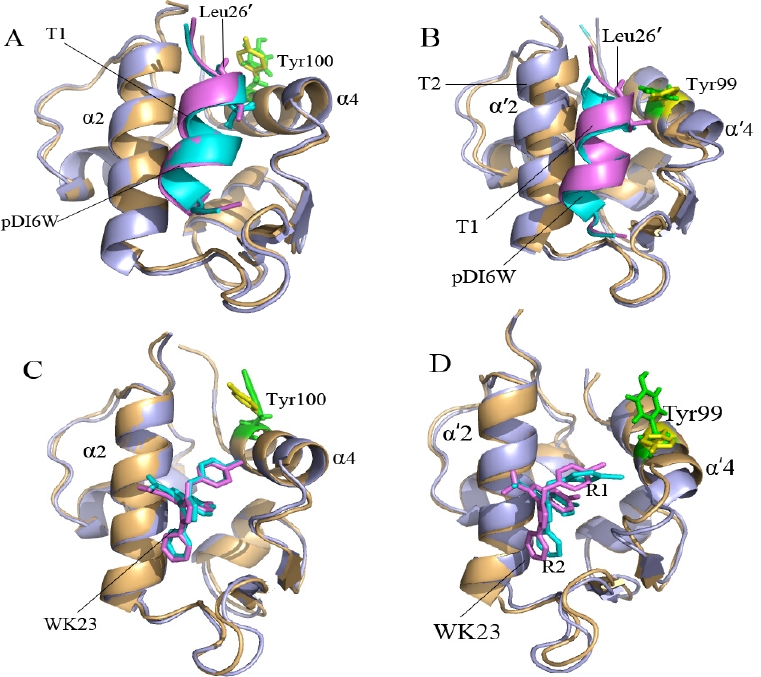
Figure 4. Crystal structures were superimposed on the average structure from the last 500 ps of molecular dynamics simulation at an interval of 10 ps, ( A ) for the pDI6W-MDM2 complex; ( B ) for the pDI6W-MDM2 one; ( C ) for the WK23-MDM2 one; and ( D ) for the WK23-MDMX one. In the average structure, protein, inhibitor and Tyr100 (Tyr99) are shown in light orange, cyan and green, respectively. In the crystal structure, the protein, inhibitor and Tyr100 (Tyr99) are displayed in light blue, violet and yellow. The residue Leu26' is from pDI6W and second structure labeled by α ' belongs to MDMX. T1 represents the residues 49–51 in MDMX and T2 indicates the residues 24 and 25 in pDI6W.